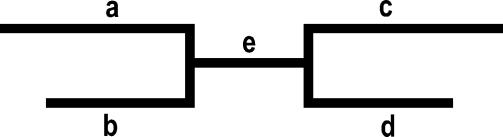
Fork Problem during Consensus ExtensionSuppose we have two TEs, each in three segments, a-e-c and b-e-d, where segment e is identically shared between the two TEs. Four results are possible (a-e-c, a-e-d, b-e-c, and b-e-d), and ReAS will compute all four paths. It then uses the overlapping reads or clone-end pairs for bridging information, and where possible, eliminates any incorrect paths.